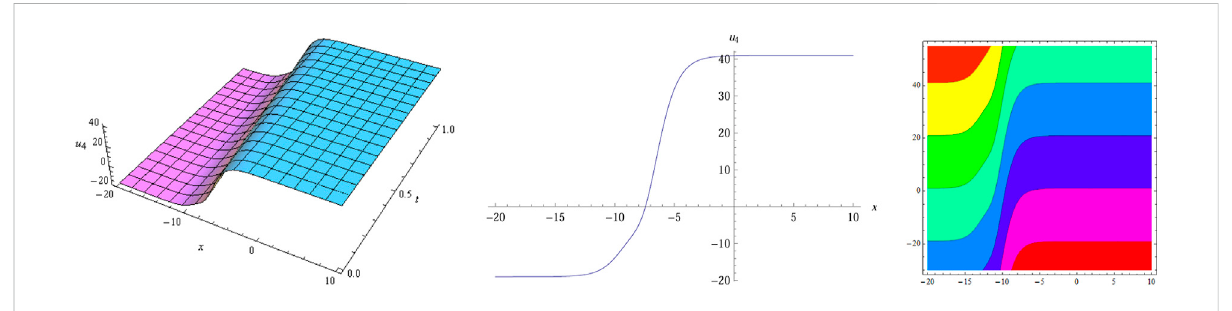
FIGURE 6 3D plot, 2D plot, and contour plot of u 4 with α (cid:2) β (cid:2)